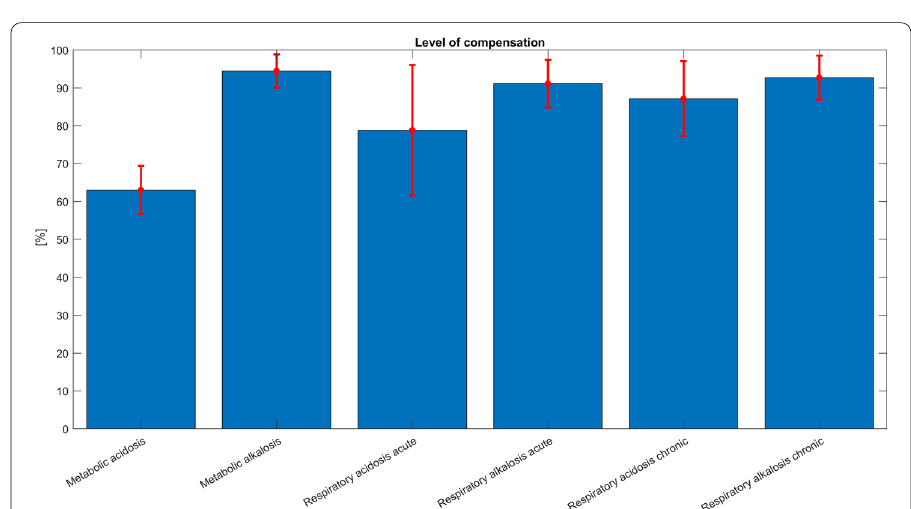
Fig. 2 Metabolic, acute and chronic respiratory acidoses were less compensated compared to corresponding alkaloses ( p < 0.01). The percentage of the compensation compensation (100%) is defined according to Boston rules, and the actual compensation is defined as a percentage of full